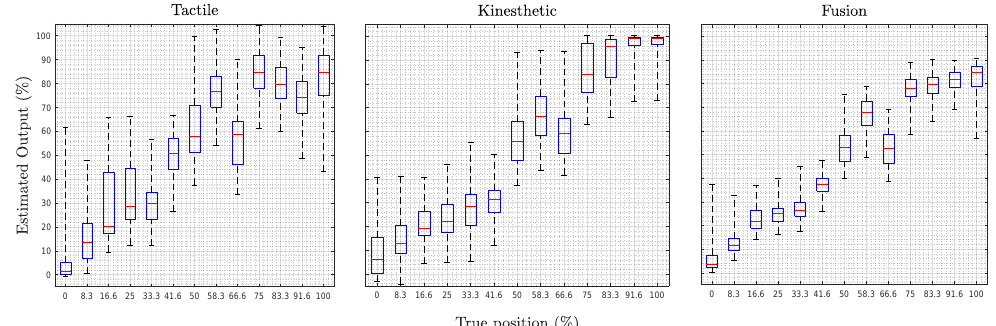
Figure 7. The median, 25/75 percentiles, and the maximum and the minimum estimation output of each X % . The test is presented for the tactile, kinesthetic, and fusion neural networks.